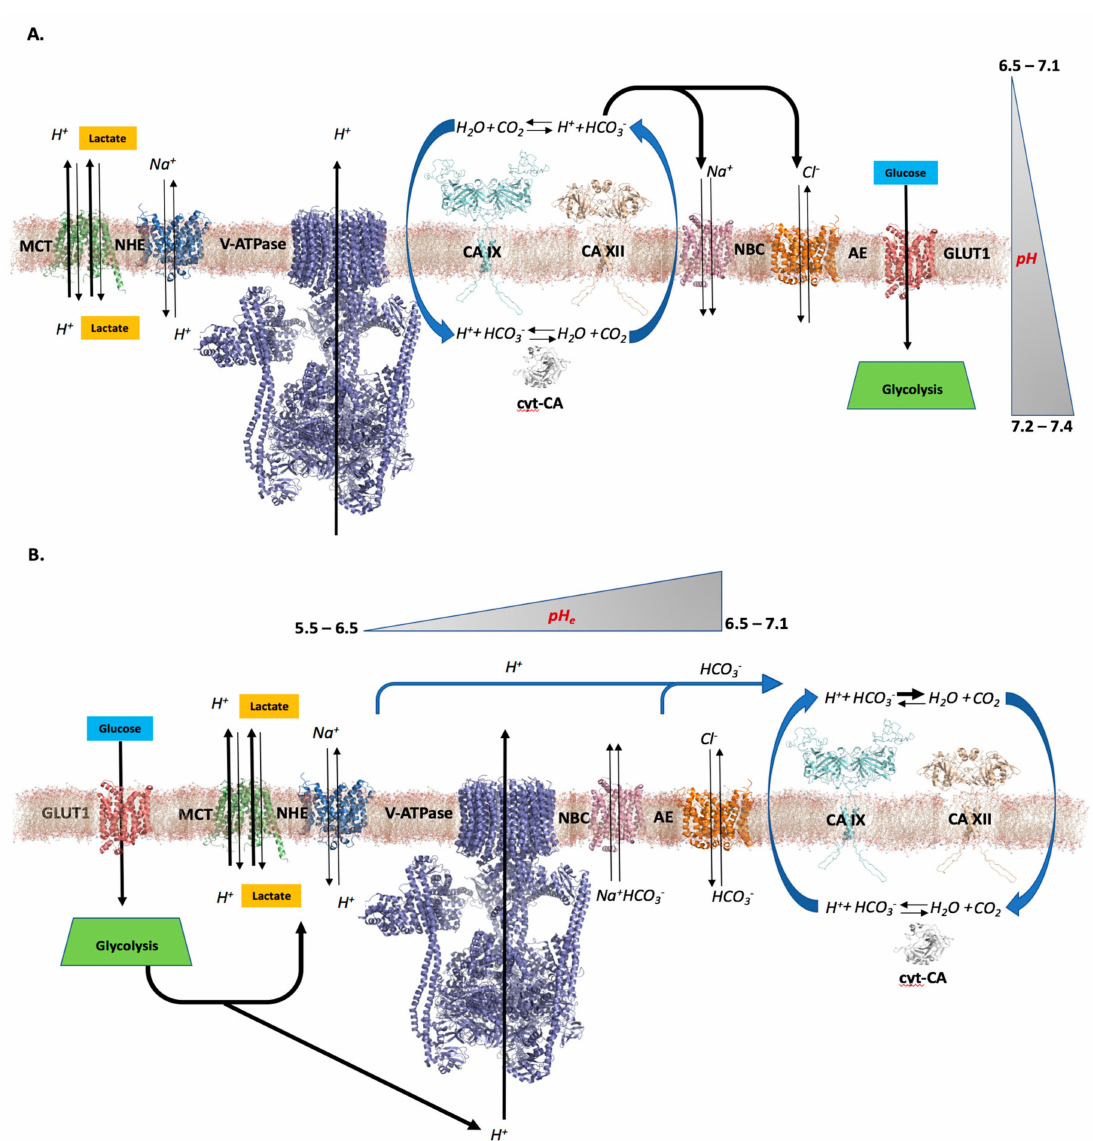
Figure 1. Illustrations of Hypothesis 1 ( A ) and Hypothesis 2 ( B ) to model the functional role of CA in the hypoxic tumor microenvironment. ( A ) Hypothesis 1: CA IX and XII (cyan and tan, respectively) are located on the extracellular membrane and adjacent to transporters involved in pH regulation. Here, CA IX and XII act in conjugation with cyt-CAs (grey) to cycle substrates of water, CO 2 , HCO 3 − , and protons, to maintain the differential pH microenvironment. ( B ) Hypothesis 2: Extracellular CA IX and XII act to raise pH e that has been reduced to levels < 6.0 due to excess expulsion of glycolysis byproducts. In this case, HCO 3 − dehydration and proton sequestration are catalytically favored by CA IX and XII. Alternatively, cyt-CAs act to convert excess CO 2 to HCO 3 − to buffer pH i and provide substrates to be transported to the extracellular surface to be utilized by CA IX and XII. Transporters shown are MCT (green), NHE (blue), V-ATPase (purple), NBC (pink), AE (orange), and GLUT1 (red). Structural models were generated using PyMol [119]. Models of CA IX and XII were generated using PDBs 5DVX [51] and 1JCZ [120], respectively. PDB 3J9T was utilized to model V-ATPase [121], and PDB 4YZF [122] was utilized to generate models of AE, NBC, and NHE. For modeling of MCT and GLUT1, PDBs 1PW4 [123] and 4PYP [124] were used, respectively. To represent cyt-CAs, PDB 3KS3 [125] was